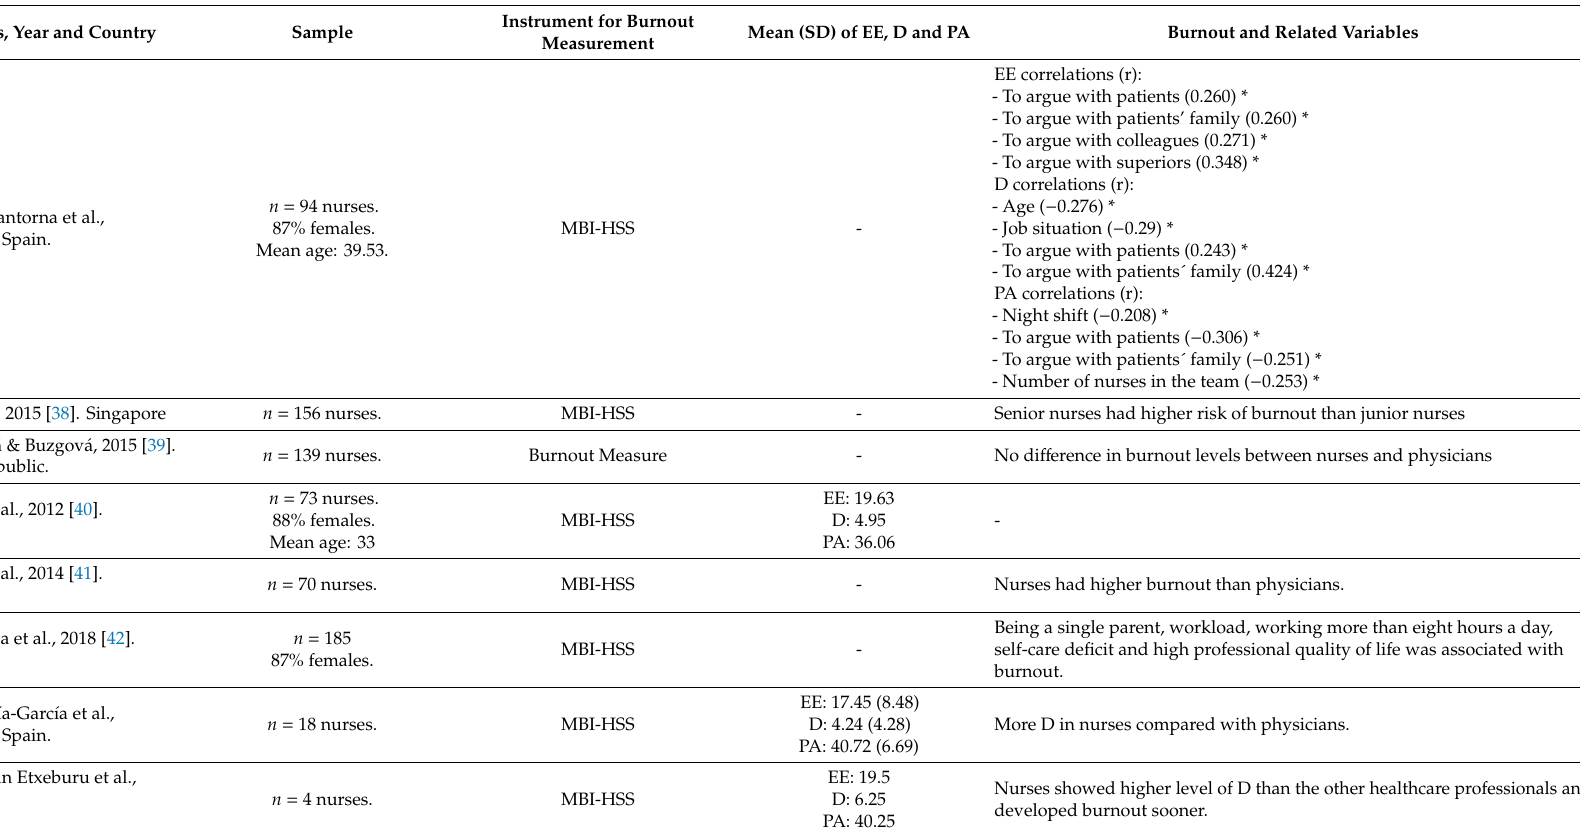
Table 1. Cont. Instrument for Burnout Mean (SD) of EE, D and PA Burnout and Related Variables Measurement EE correlations (r): - To argue with patients (0.260) * - To argue with patients’ family (0.260) * - To argue with colleagues (0.271) * - To argue with superiors (0.348) * D correlations (r): -